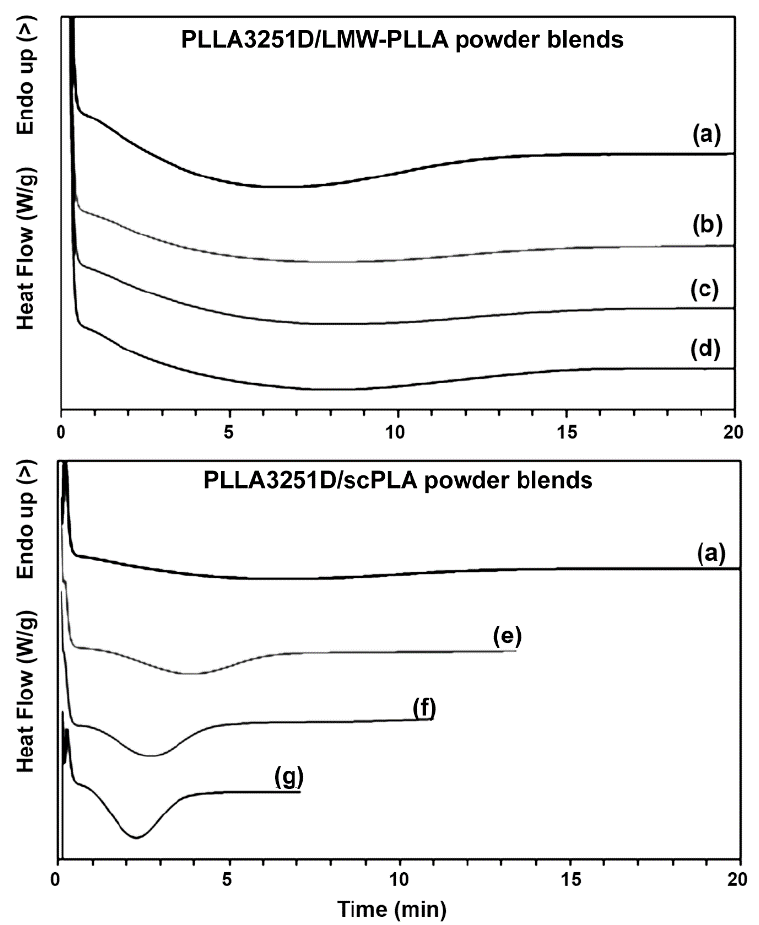
Figure 7. DSC isothermal curves at isothermal temperature of 120 °C of ( a ) pure PLLA3251D and PLLA3251D/LMW-PLLA powder blends with powder contents of ( b ) 2%, ( c ) 4%, and ( d ) 8% w / w as well as PLLA3251D/scPLA powder blends with powder contents of ( e ) 2%, ( f ) 4%, and ( g ) 8% w / w .